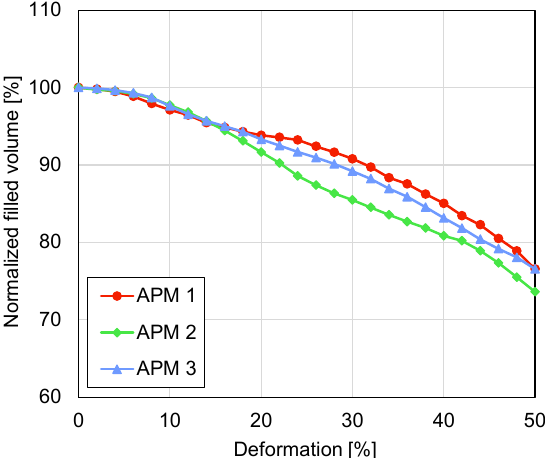
equal 76.6%, 73.6% and 76.6% for APM foam samples 1, 2 and 3, respectively.